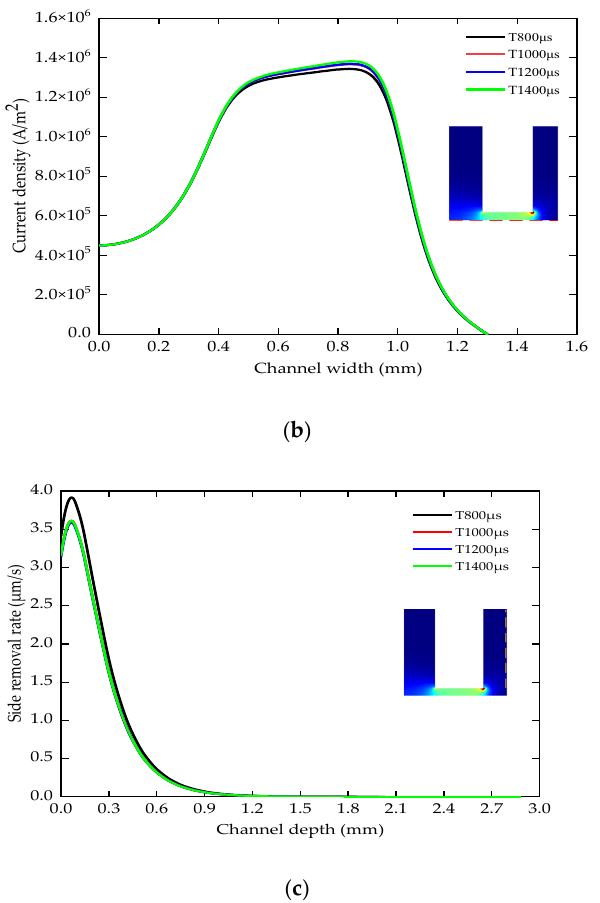
Figure 8. The temperature, current density and side removal rate of various pulse periods; ( a ) the change of the temperature; ( b ) the change of the current density; ( c ) the change of the side removal rate.